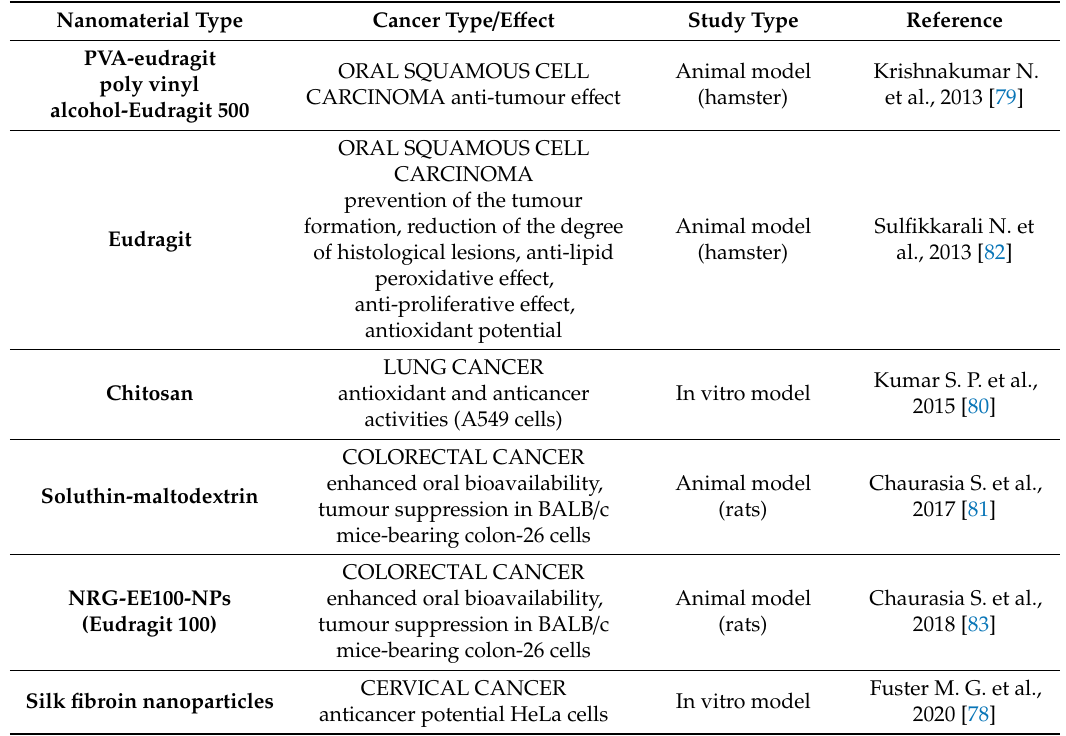
Table 6. Anticancer e ff ect of naringenin nanoparticles in in vivo studies. Nanomaterial